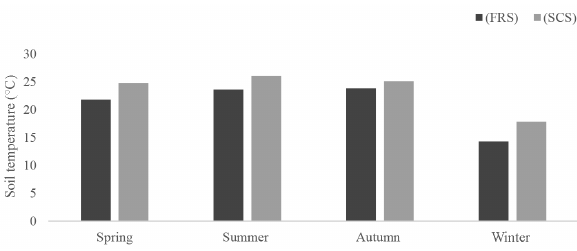
SCSFigure 2. Seasonal variation in soil moisture at FRS and